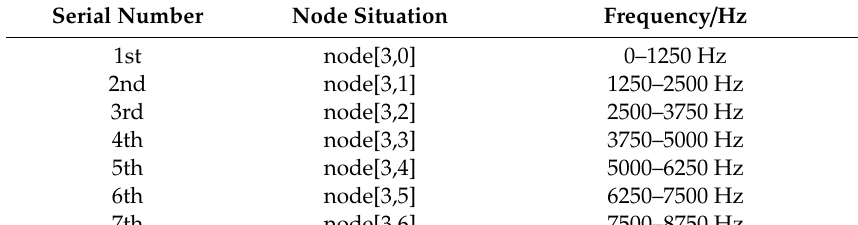
Figure 5. The results of the fast kurtogram (FK) ( a ) db1; ( b ) db2; ( c ) db3; ( d ) db4; ( e ) db5.